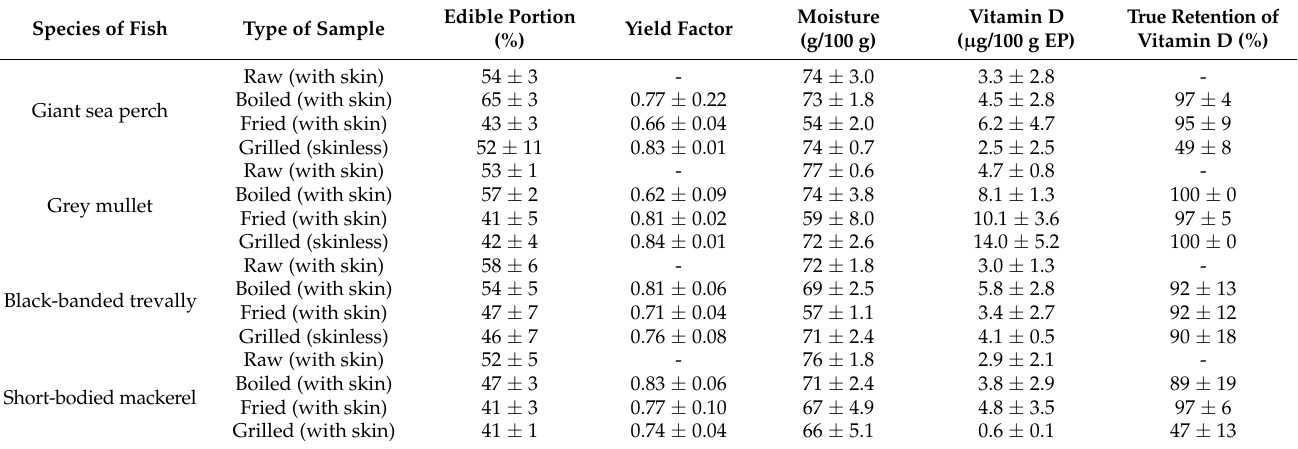
Table 4. Percentage of edible portion, yield factor, moisture, vitamin D, and true retention of 3 individual sets from each type of marine fish, data expressed as mean ± SD ( n = 3).